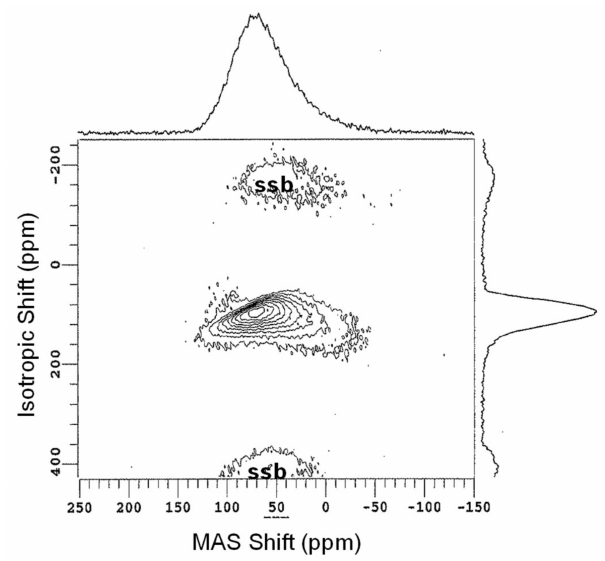
Figure 10. An example of 45 Sc 3QMAS NMR (at 11.7 T) data for a Sc-containing sodium silicate glass (15Sc 2 O 3 ) [71]. Isotropic and MAS projections are shown to the right and top, respectively. Average position of the 45 Sc resonance in these two dimensions can be used to determine isotropic chemical shift and quadrupolar coupling product, the latter related to the 45 Sc quadrupolar coupling constant [76]. Data were collected using a 3.2-mm MAS NMR probe, with a sample volume of 22 mL and spinning of 20 kHz. Both 45 Sc MAS (data not shown) and 3QMAS NMR data were acquired relatively quickly, with adequate data collected in several hours for each